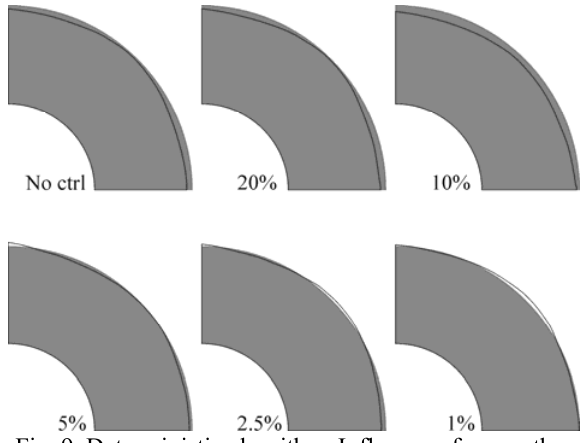
Fig. 9. Deterministic algorithm. Influence of γ over the op- timal solution found (black contour) and comparison with optimal analytical solution (shaded area).